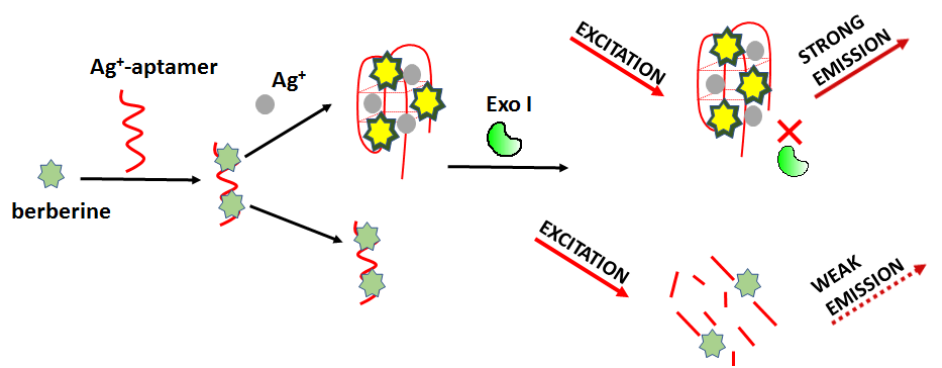
Figure 16. Schematic representation of Ag + detection based on Exonuclease I-aided fluorescence ap- tasensor.